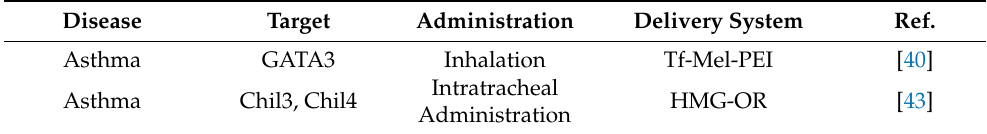
Table 3. Research of inhaled siRNA formulations for chronic respiratory diseases.